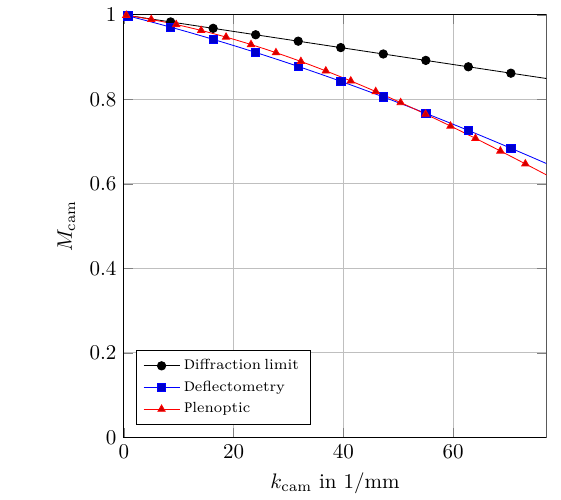
Figure 2. Deflectometric camera MTF for defocused image of screen points with 1.0m distance and focal plane distances g